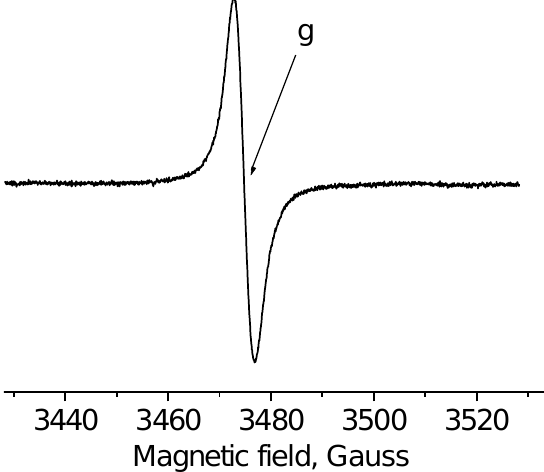
Figure 3. The electron paramagnetic resonance (EPR) spectra of the studied samples of HAs consists of one signal with  H pp at about 4 G typical for the radical species. one signal with ∆ H pp at about 4 G typical for the radical